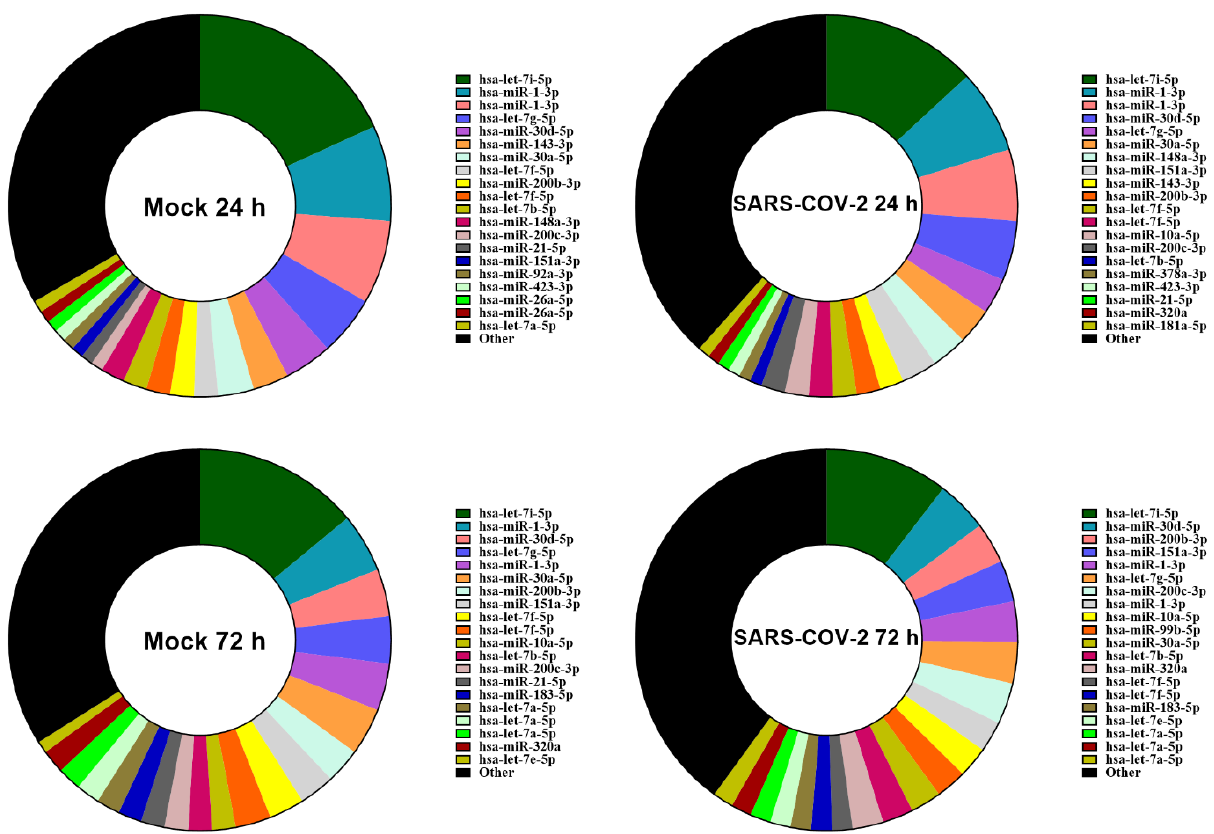
Figure 2. miRNA expression profiling of Calu-3 cells infected or not with SARS-CoV-2 virus. Circular diagram representing the 20 most abundant microRNAs in each experimental condition (Mock- or SARS-CoV-2-infected; 24 h and 72 h) along with other microRNAs and their relative proportions assessed by RNA-Seq. The ranking was based on the normalized tag number of miRNAs averaged from 3 biological replicates.